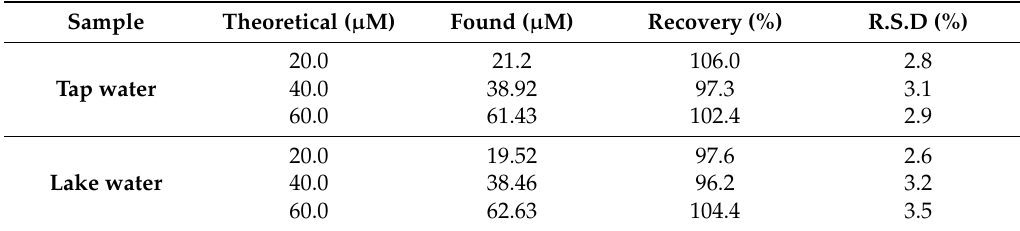
Table 2. Determination of nitrite at various concentrations in tap and lake